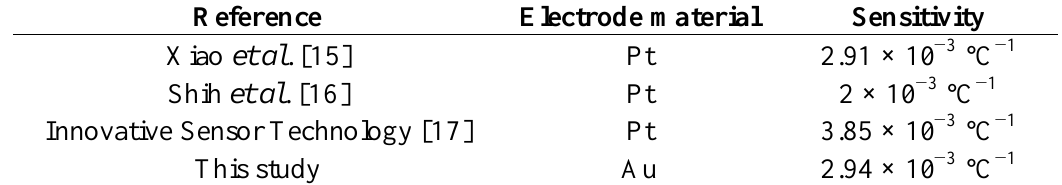
Table 2. Comparison of sensitivity for different resistive temperature sensors presented in the literature.